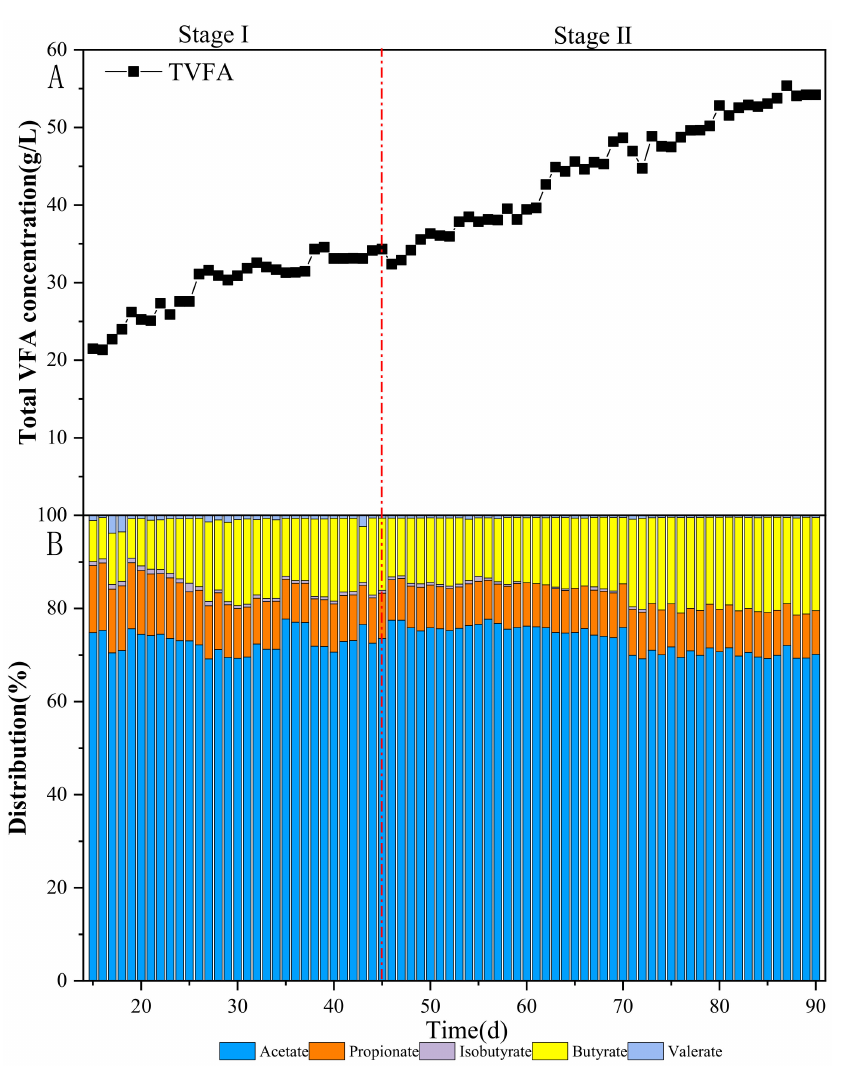
Figure 2. ( A ) Variations of total VFA concentration; ( B ) different VFAs’ distribution in the